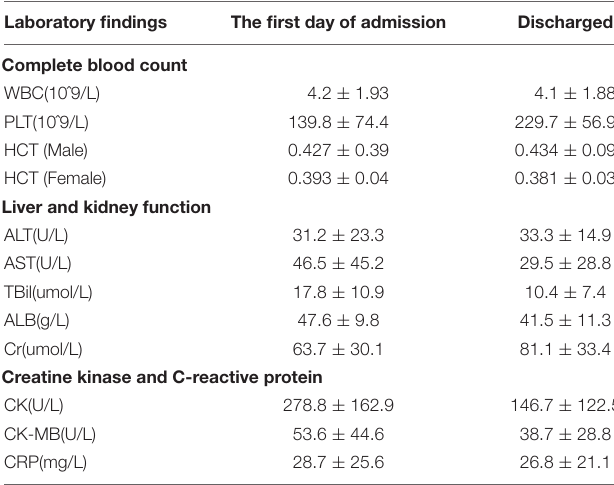
TABLE 2 | Laboratory findings in patients with DF.